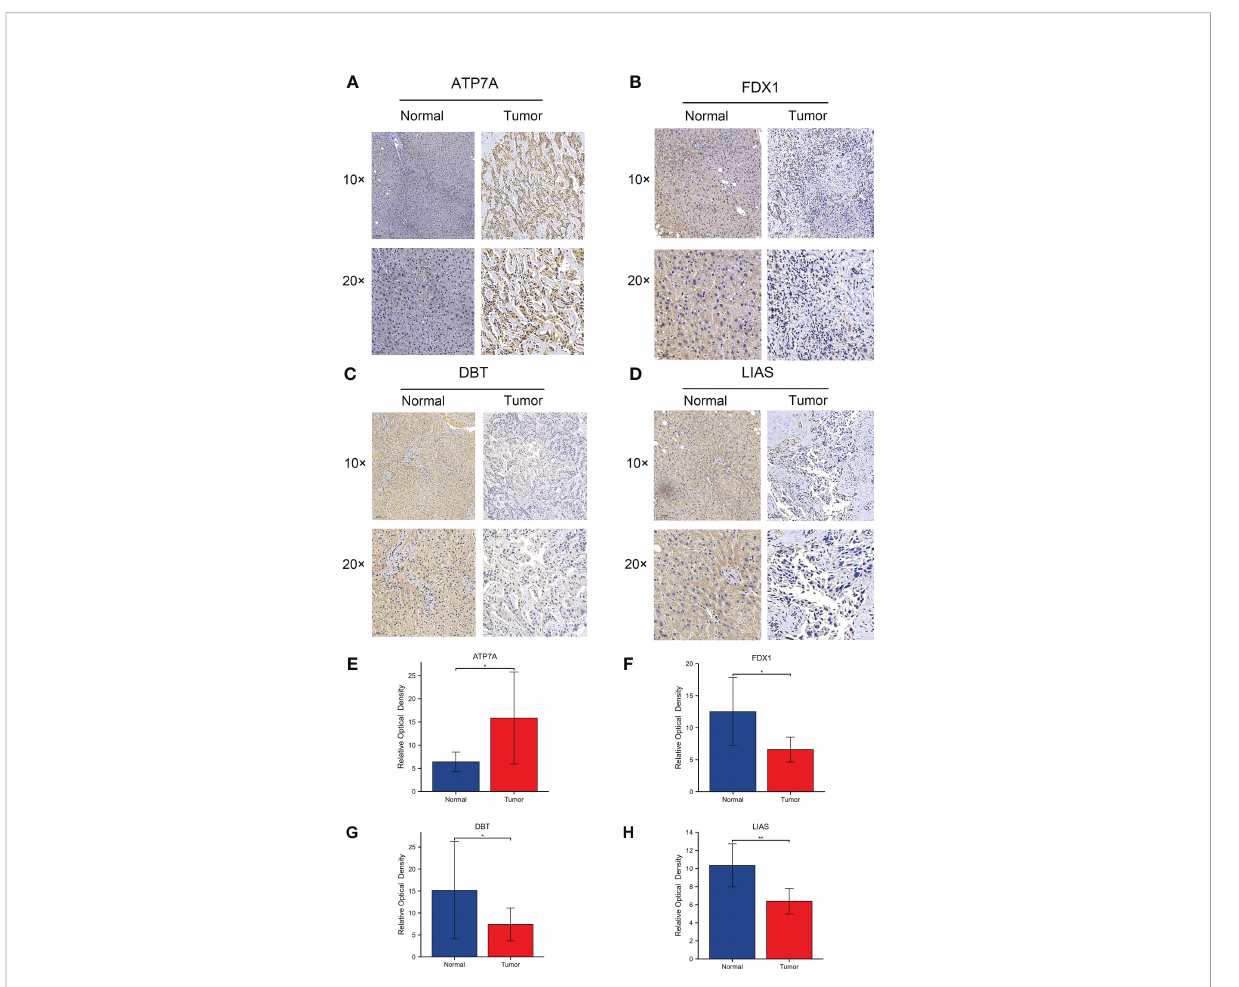
FIGURE 8 Protein expression levels of 4 CRGs using immunohistochemistry. (A – D) The expression levels of ATP7A, FDX1, DBT and LIAS in adjacent normal tissues and tumor tissues. (E – H) Relative optical densities of the 4 genes (*p < 0.05, **p <